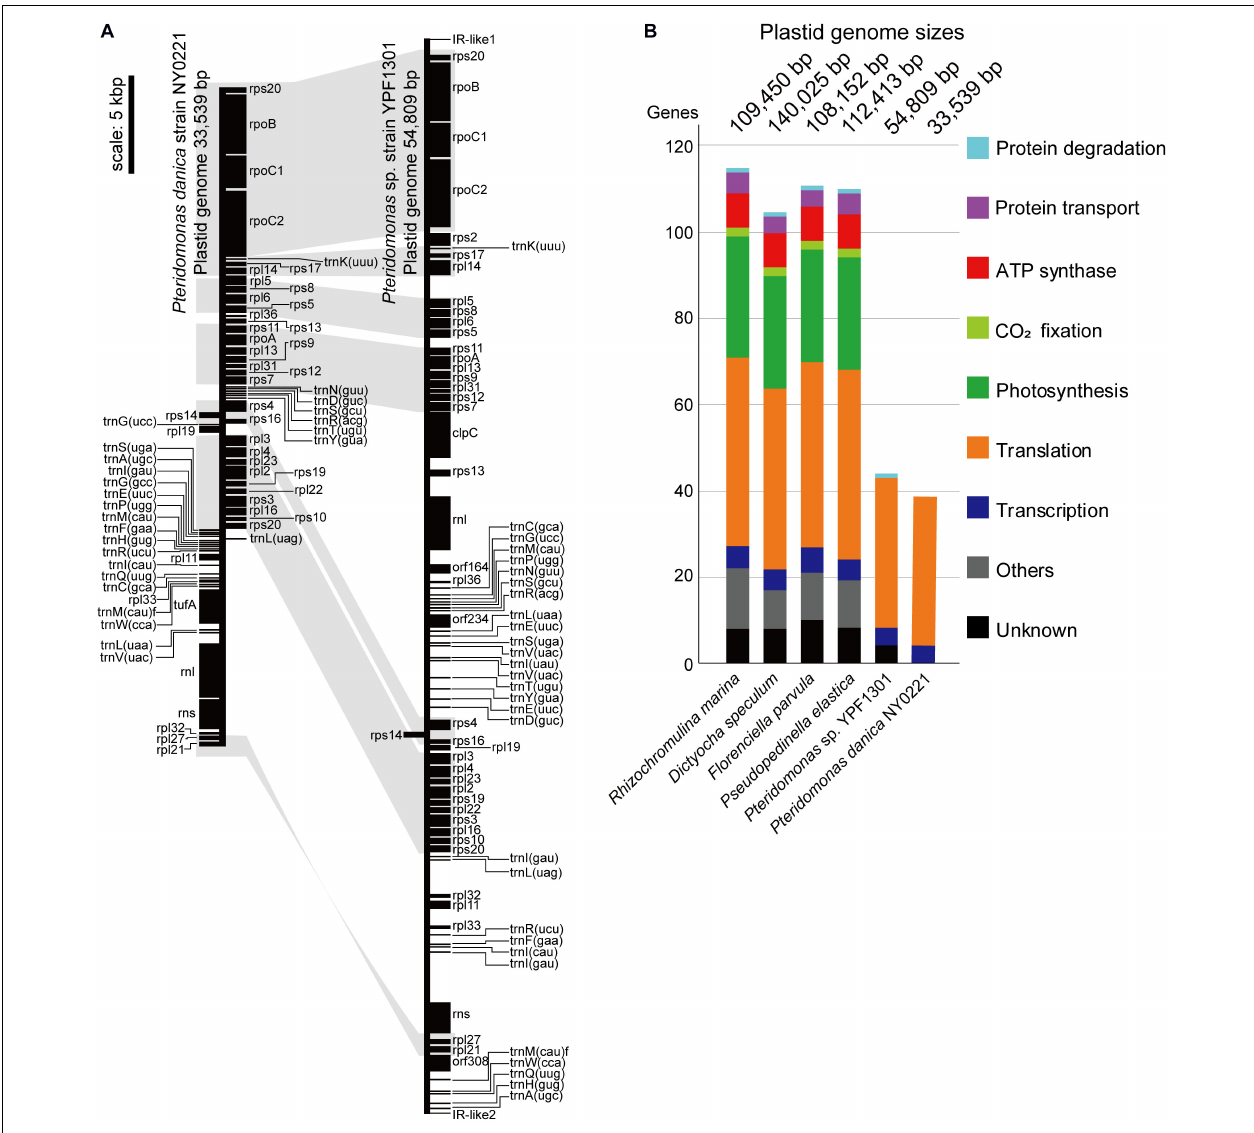
FIGURE 2 | Plastid genomes of Pteridomonas sp. strain YPF1301 and Pteridomonas danica strain NY0221. (A) Plastid genome maps. The genomes are shown as linear for comparison of gene locations although the genome of strain NY0221 is a circularly mapping molecule ( Supplementary Figure S1 ). Protein-coding and ribosomal RNA-coding regions are shown as black boxes. Transfer RNAs are shown as black lines. Conserved gene orders are highlighted in light gray. (B) Comparison of plastid-encoded genes and genome sizes among the photosynthetic and non-photosynthetic species of Dictyochophyceae (Han et al., 2019). Any color boxes show functional categories: light blue for protein degradation ( clpC ), violet for transport ( sec , tatC ), red for ATP synthase ( atp ), light green for CO 2 fixation ( rbcL ), green for photosynthesis ( psa , psb , pet ), orange for translation ( rps , rpl , tufA ), blue for transcription ( rpo ), gray for other known functions, black for unknown functions (orf, ycf